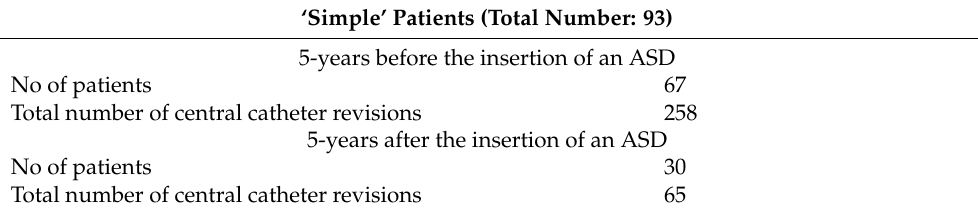
Table 5. Comparison of the number of patients who underwent revision of the proximal catheter in a time period of five years before and five years after the insertion of an ASD, in the subgroup of ‘Simple’ patients.